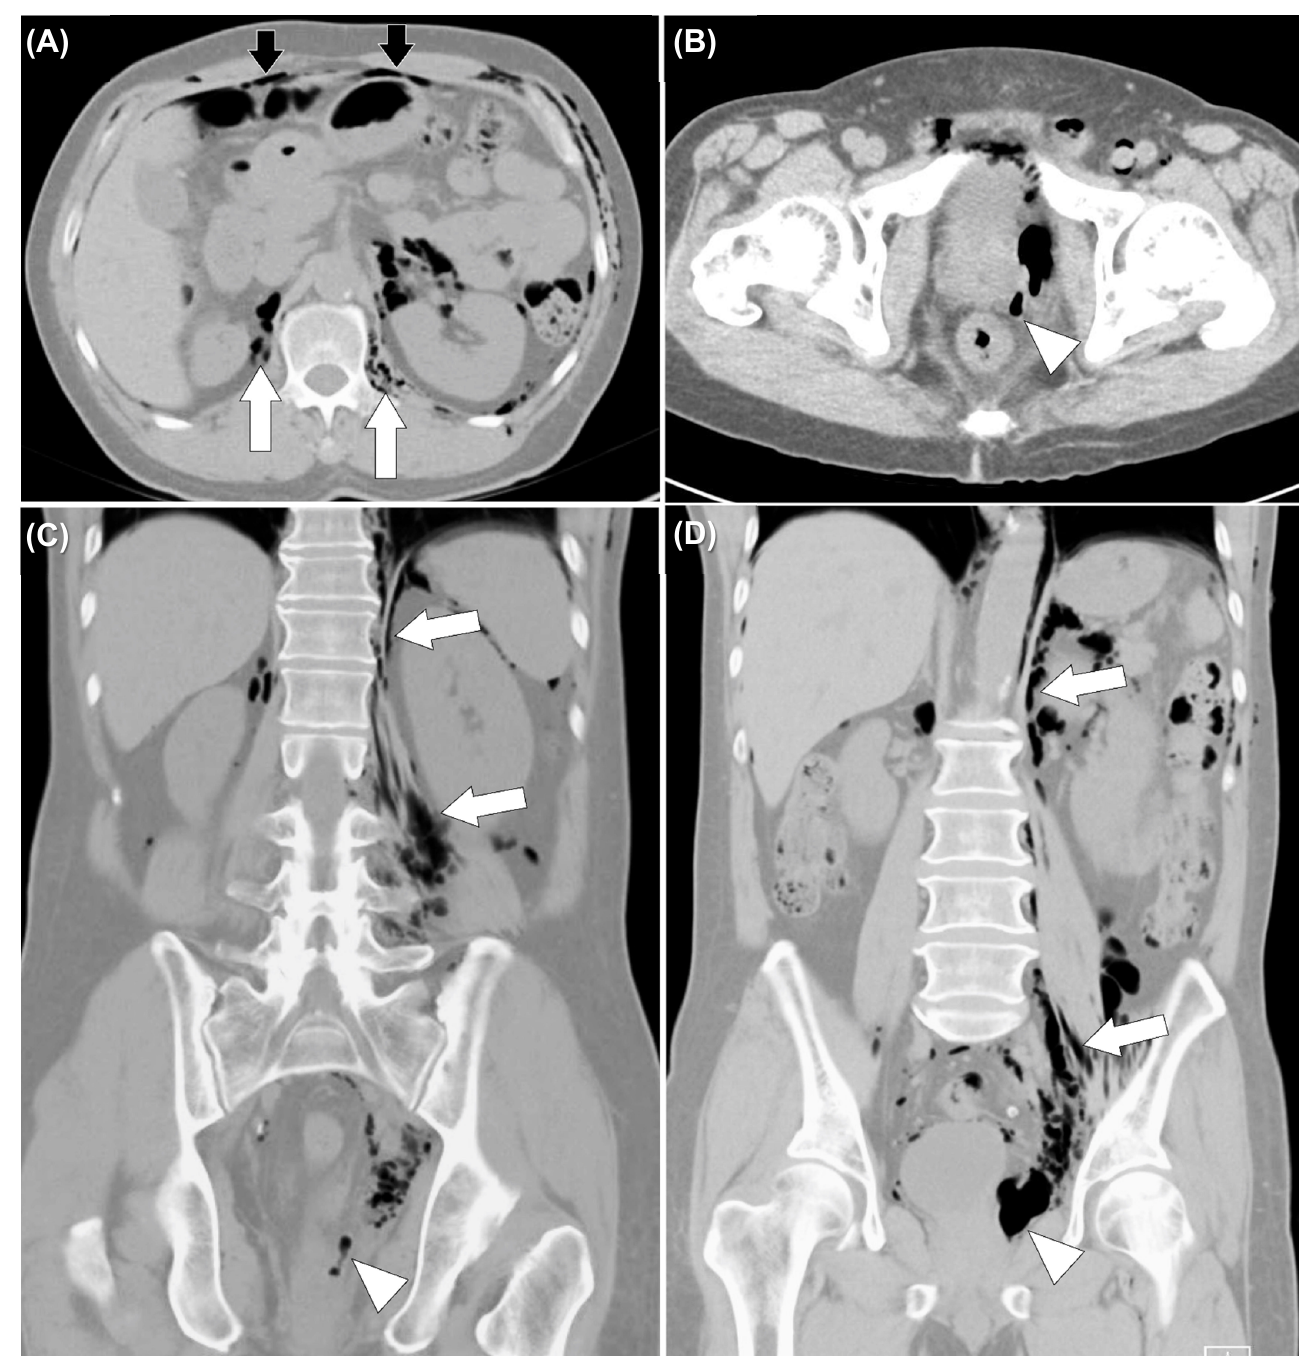
Figure 3. Non-enhanced computed tomography of the abdomen showed air tract extended from left peri-rectal area (white arrowheads) ( B – D ) to retroperitoneum (white arrows) ( A , C , D ), and peritoneum (black arrows) ( A ).